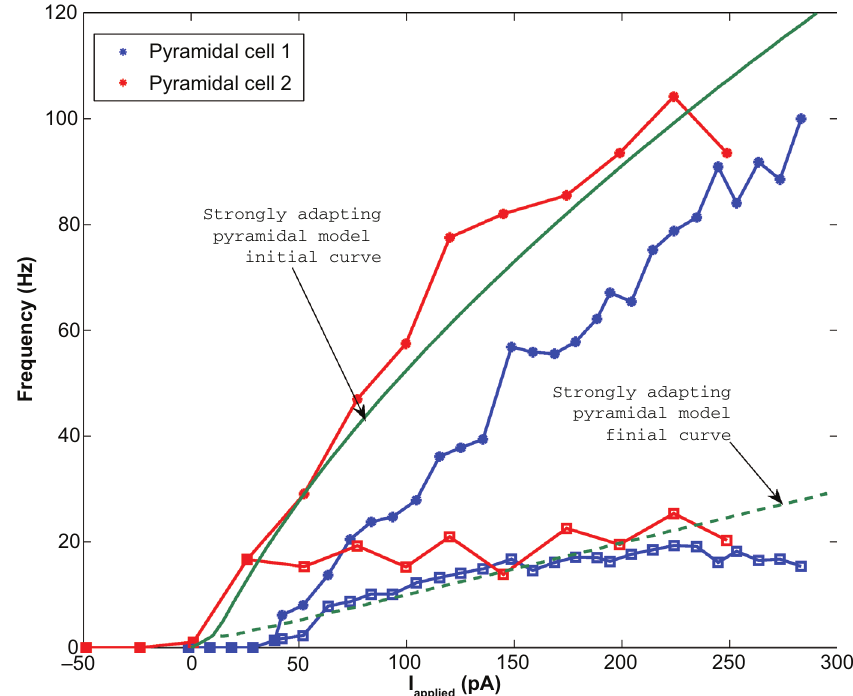
Figure 3. The strongly adapting pyramidal cell f-I curves (Pyramidal cells 1 and 2 shown in blue and red respectively) are shown against the strongly adapting pyramidal cell model (dark green). The initial data points are shown as asterisks and the final points shown as squares. The initial model curve is shown as a solid line (initial slope: 0.432), and the final curve shown as a dashed line (final slope: 0.099). The model rheobase (~0 pA) and slope approximate those determined